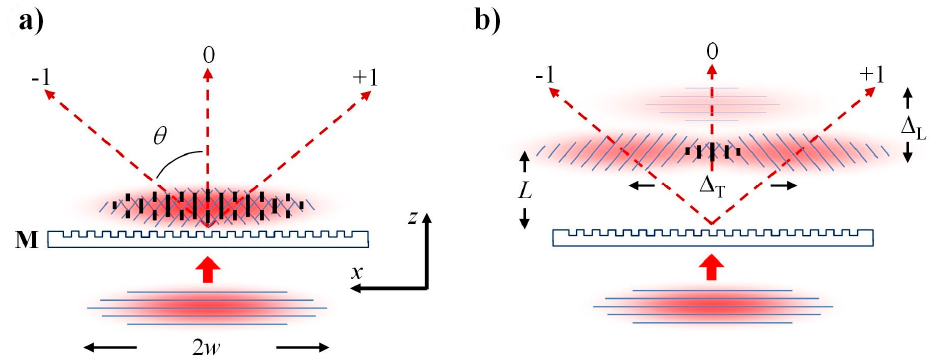
Figure 4. Interference of ultrashort pulses after a phase mask that produces only the 0th and 1st diffraction orders. ( a ) A complex Talbot-like interference pattern formed near the phase mask (M) when the distance L from M is small. ( b ) Transverse ( ∆ T ) and longitudinal ( ∆ L ) walk-offs become pronounced as L is increased. The pulse phase fronts are schematically depicted with blue lines.